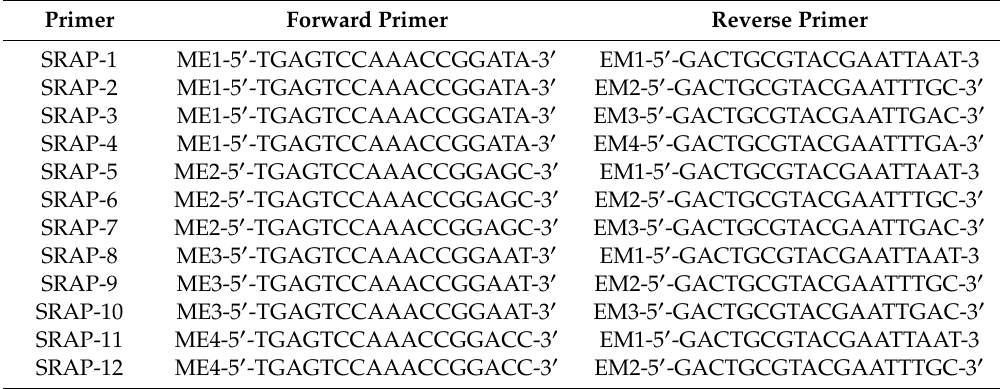
Table 2. Sequence-related amplified polymorphism (SRAP) primers used in this